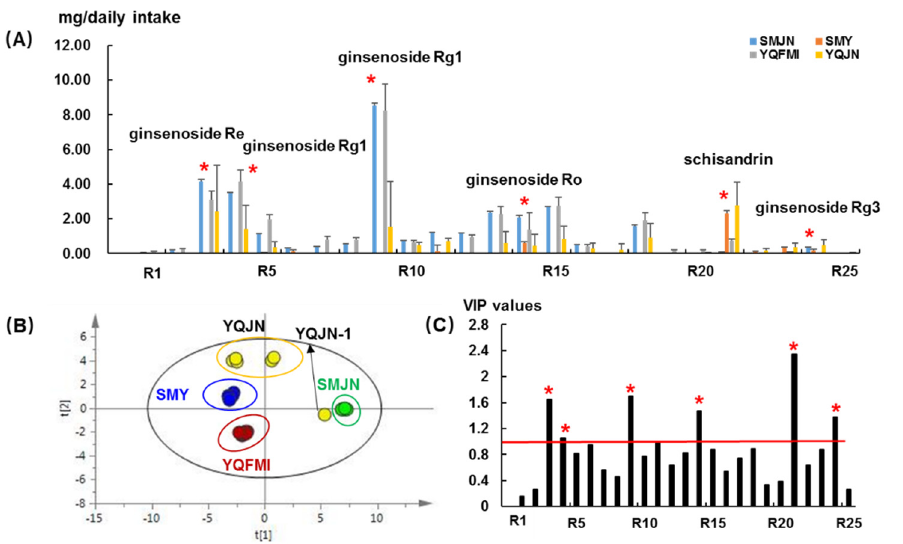
Figure 4. ( A ) The maximum daily intake of 25 compounds when using different SMS-based patent drugs; ( B ) PCA scatter plots for 30 batches of samples; ( C ) VIP values for 25 analytes in different SMS-based patent drugs, x -axis represents the first principal component, which explains 62.0% of the total variance, y -axis represents the second principal component, which explains 19.7% of the total variance, * represents for the compounds with VIP values > 1.0.